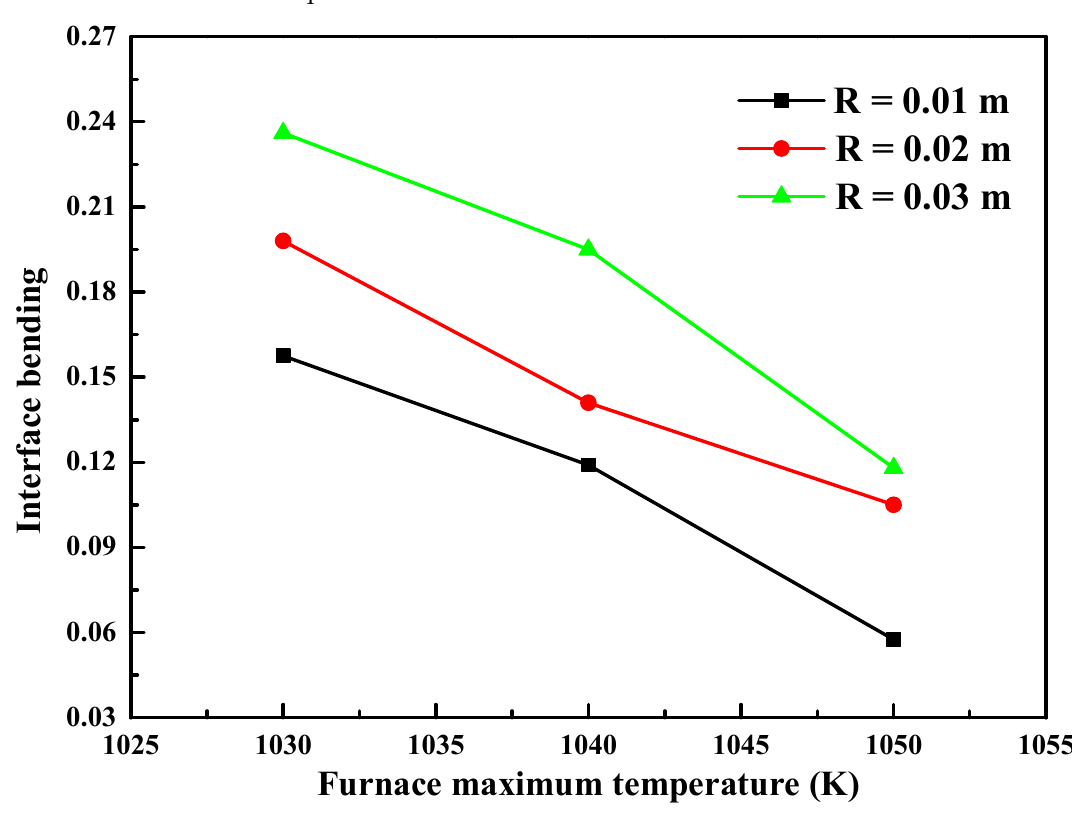
Figure 4. The effects of the furnace maximum temperature and the crystal radius on the growth solid–liquid interface bending when the melting zone is 0.08–0.12 m away from the bottom of the crucible.